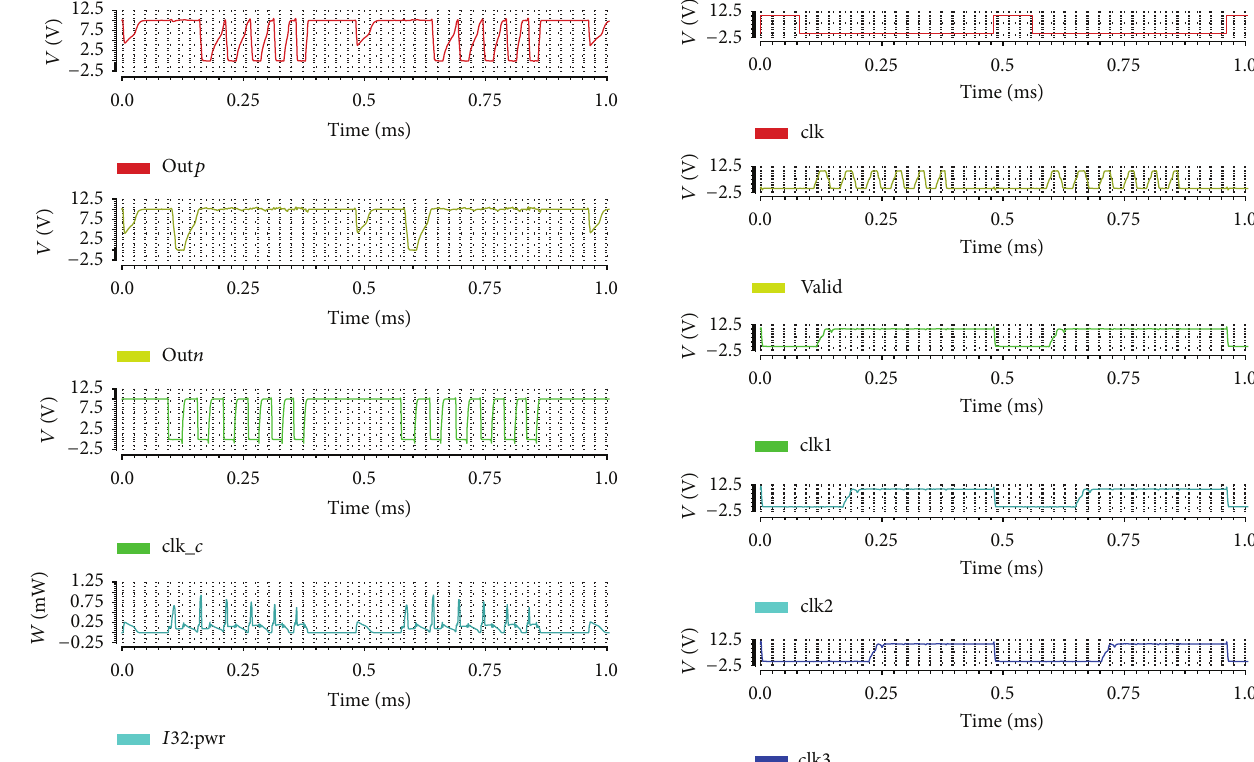
Figure 13: Waveforms of outputs (Out 𝑝 , Out 𝑛 ), control clock signal (clk 𝑐 ), and power consumption of dynamic comparator ( I 32:pwr).